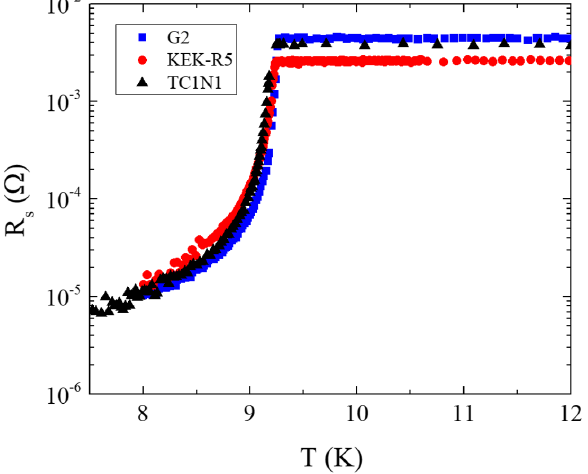
FIG. 9. Surface resistance versus temperature between 7.5 K and 12 K measured on cavity TC1N1 after EP, KEK-R5 after LTB and G2 after N-doping.